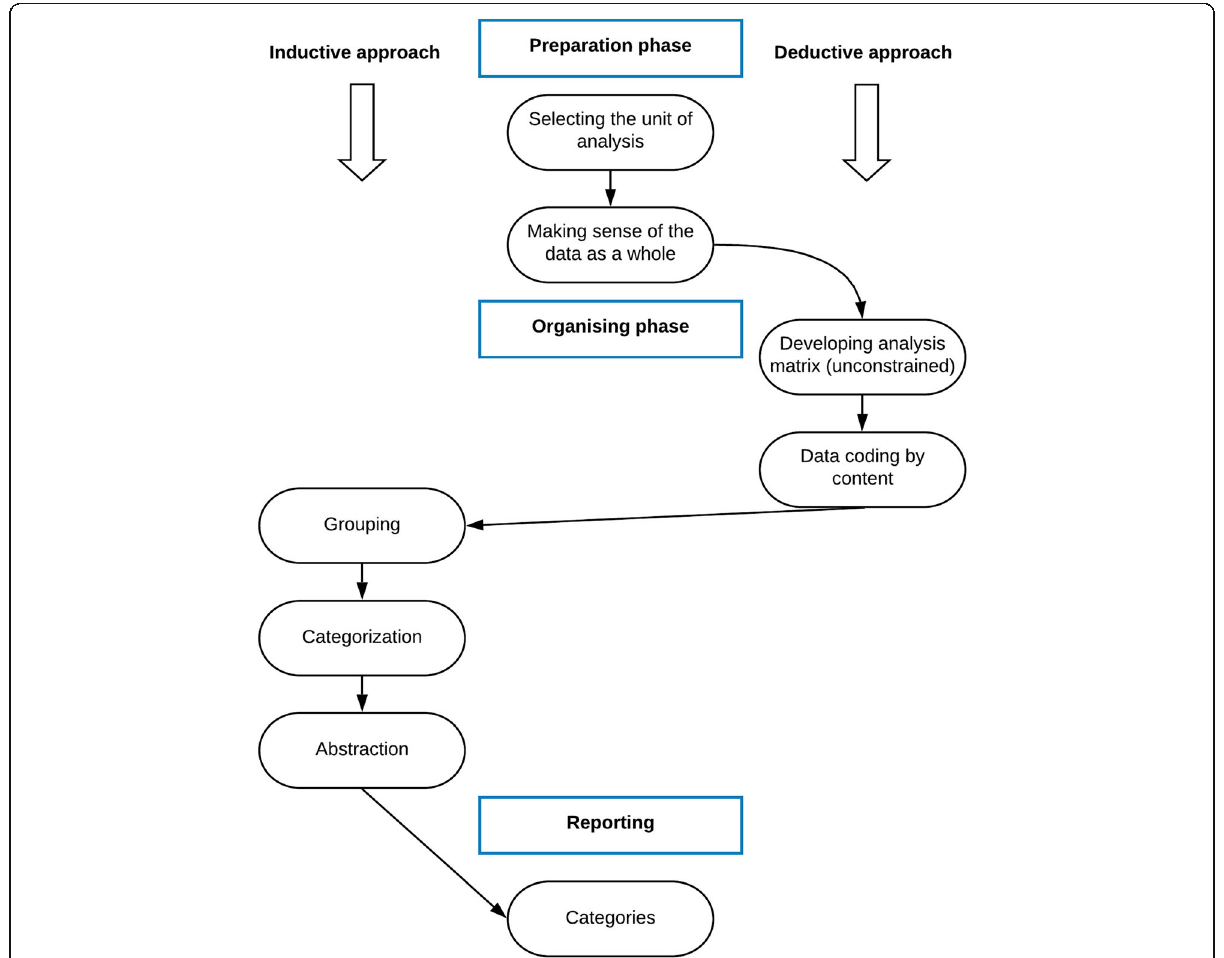
Fig. 2 Overview of the analysis process, modified from [39], used with